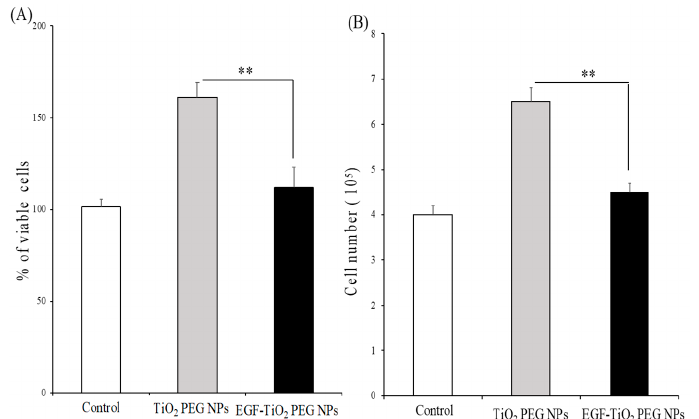
Figure 3. Effect of non-conjugated and EGF-conjugated TiO 2 PEG NPs on A431 cell viability ( A ) and growth ( B ). A431 cells were treated by TiO 2 PEG NPs (gray bar) and EGF-TiO 2 PEG NPs (black bar) at a concentration of 10 µg/mL for 24 h. The effect of NPs on cell viability and growth was calculated compared to control untreated cells (white bar). All values are presented as means ± SD ( n ≥ 3). Data were analyzed using the Student’s t -test; ** p ≤ 0.01.